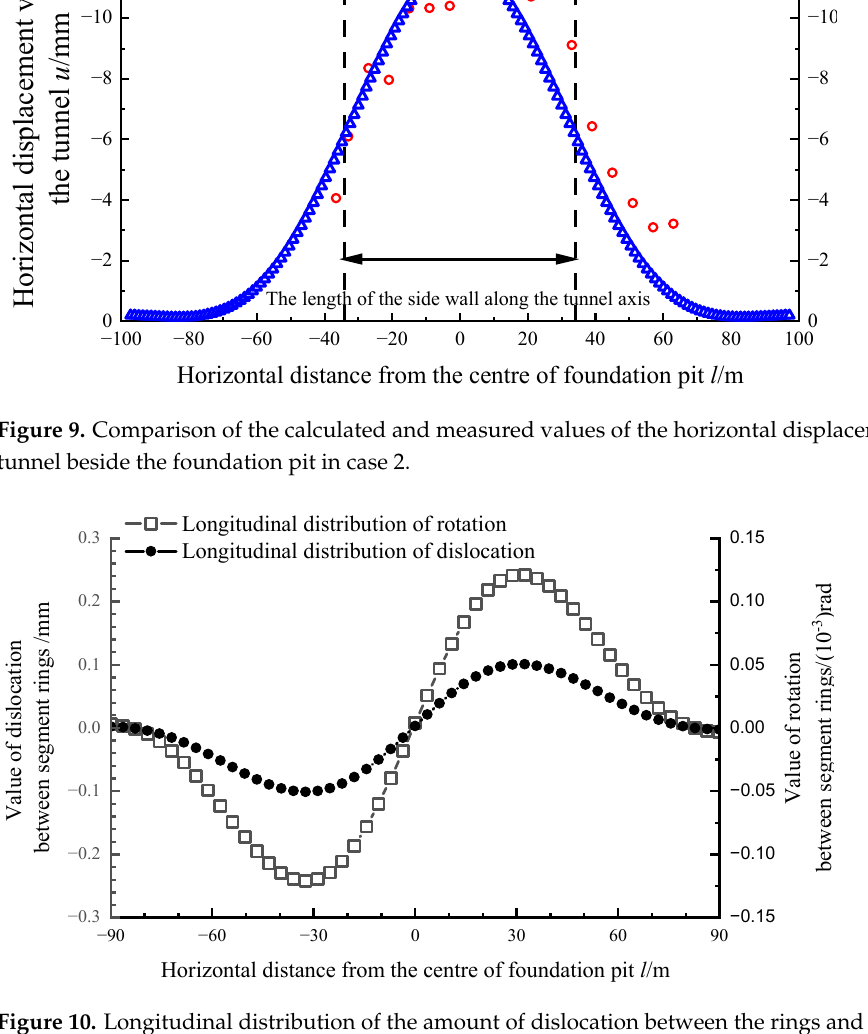
Figure 10. Longitudinal distribution of the amount of dislocation between the rings and the corners between the shield tunnels in case 2.